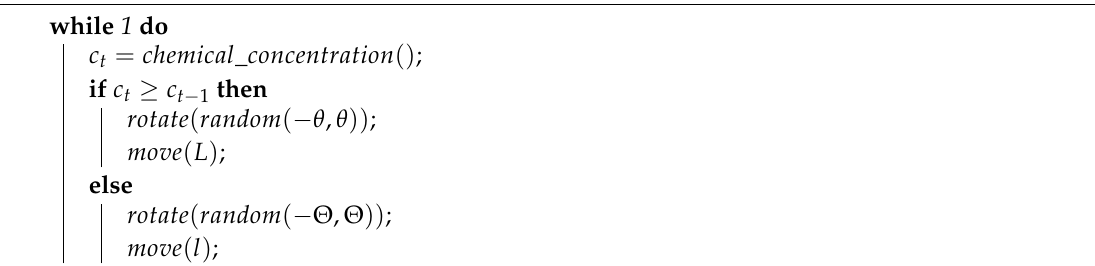
Algorithm 1: Pseudocode of the algorithm inspired by the behaviour of the E. coli bacteria [12].